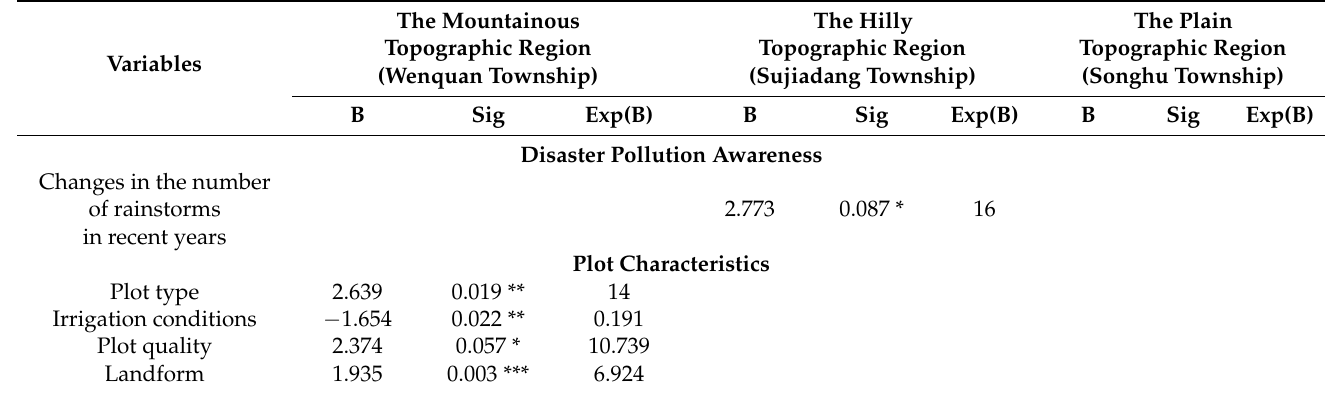
Table 7. Abandonment factors of part-time households in three topographic